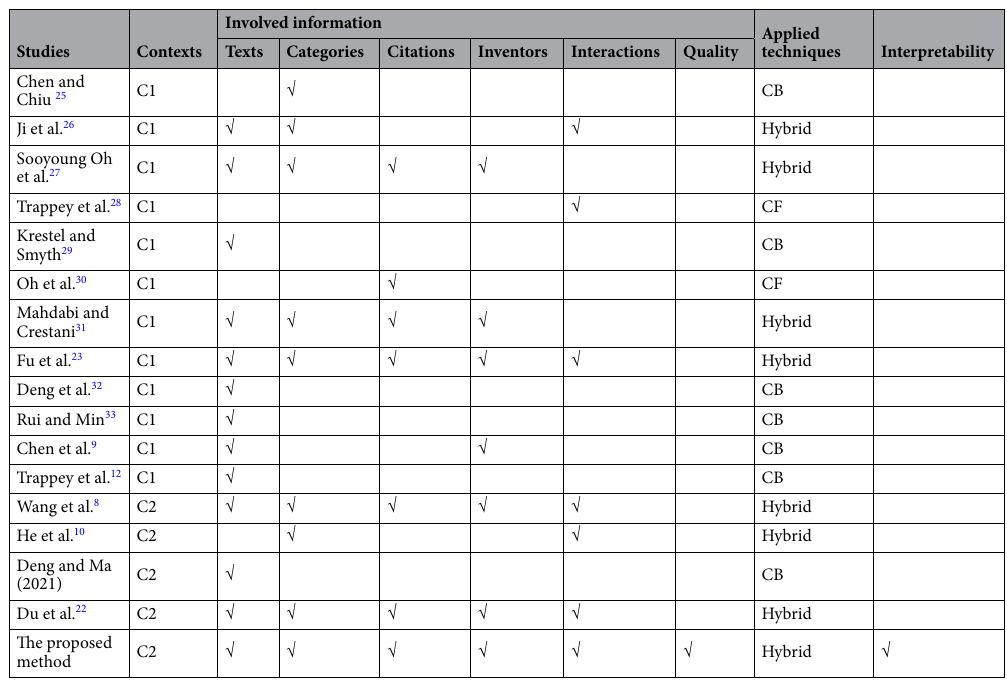
Table 1. Major studies on patent recommendations. C1 is the query-driven patent search context, C2 is the patent transfer context, CB represents content-based recommendation methods, and CF represents collaborative filtering recommendation